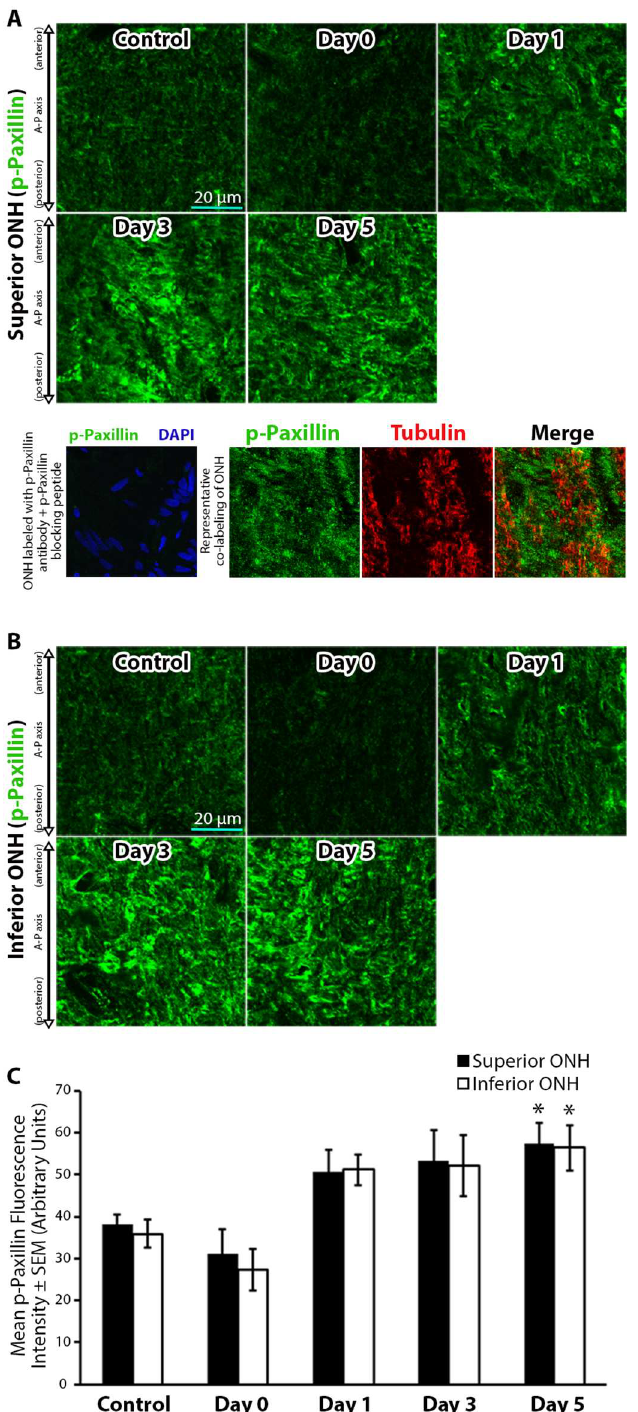
Fig 4. Paxillin phosphorylation levels within the optic nerve head increase and remain elevatedafter intraocular pressureelevation. (A-B) Superiorand inferior optic nerve head (ONH) sections labeledwith anti-phosphorylatedpaxillin(p-paxillin) antibodiesin control eyes and eyes exposedto 8 hours of intraocular pressure(IOP) elevation. The bottom panelsin (A) includea validation of antibodyspecificity using a p-paxillin specific blockingpeptide(bottom left panel), as well as an exampleof co-labelingwith p-paxillinand axon specific anti-tubulin antibodiesto demonstrate the non-axonalsource of the majority of p-paxillinlabel